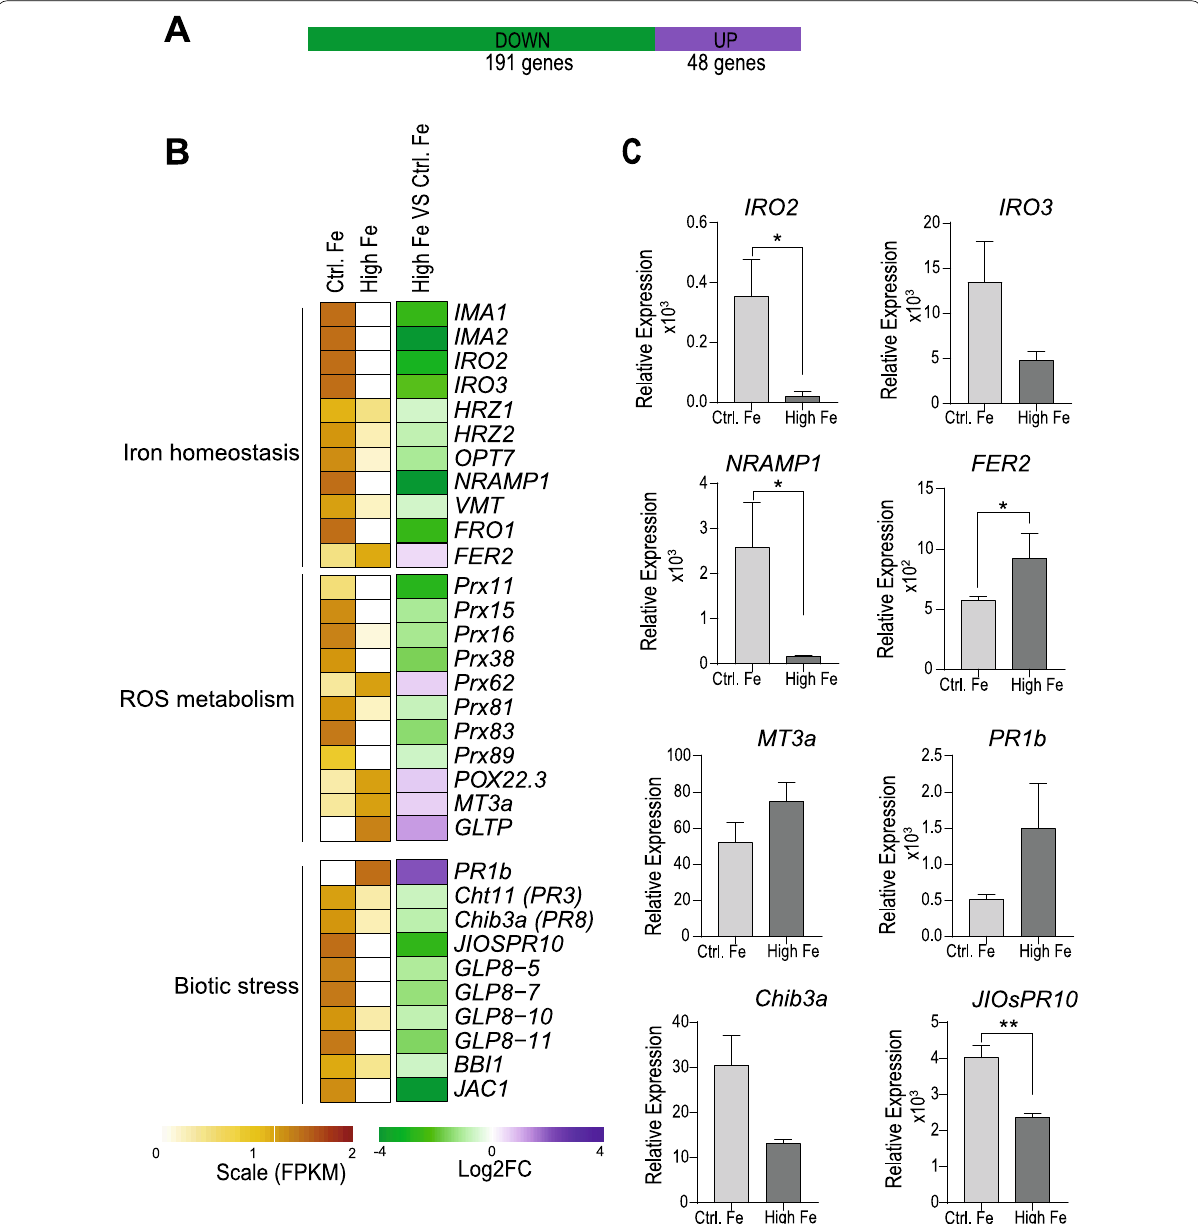
Fig. 2 Differentially expressed genes in leaves of High‑Fe plants relative to Control plants. A Number of genes that are up‑regulated and down‑regulated genes in leaves of rice plants treated with high Fe for 5 days. B Heatmap showing the expression of genes involved in Fe homeostasis, ROS metabolism and biotic stress identified as differentially expressed by RNA‑Seq analysis. The expression level (row scaled FPKM, fragments per kilobase per million reads) is represented from pale yellow (less expressed) to brown (more expressed). Fold change (FC) values are represented on the right, in purple (up‑regulated genes, Log 2 FC 0.5) and green (down‑regulated genes, Log 2 FC 0.5). Data represented ≥ + ≥ − correspond to the mean of two biological replicates, each biological replicate consisting in a pool of 5 leaves from individual plants. The full gene mean SEM (n 4 biological replicates, including the two replicates used for RNA‑Seq analysis). Asterisks indicate statistically significant differences ± = ( t ‑test, *, P < 0.05; **, P < 0.01). Gene‑specific primers are listed in Additional file 9: Table